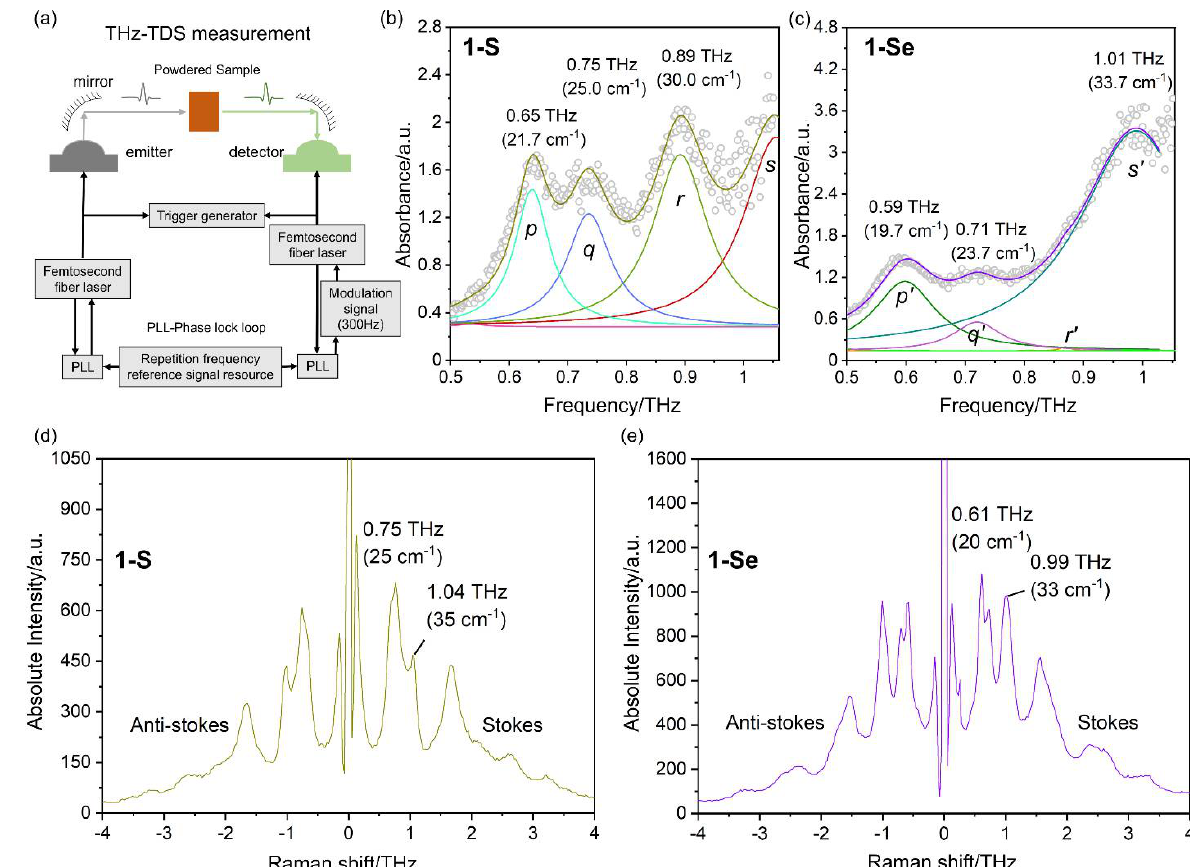
Figure 2. ( a ) Calculated vibrational IR active modes, and ( b – d ) graphic representations of the lowest energy phonon modes: 2, 4, and 5, for 1-S . The blue, black, and orange arrows indicate the vibration vectors. The numbers on top of the bars in ( a ) correspond to the vibrations in ( b – d ), and the height of these bars represents their calculated relative intensity. Graphical representations of vibrations 1 and 3 have been omitted due to the imaginary nature of the first peak and the low intensity of the second one.